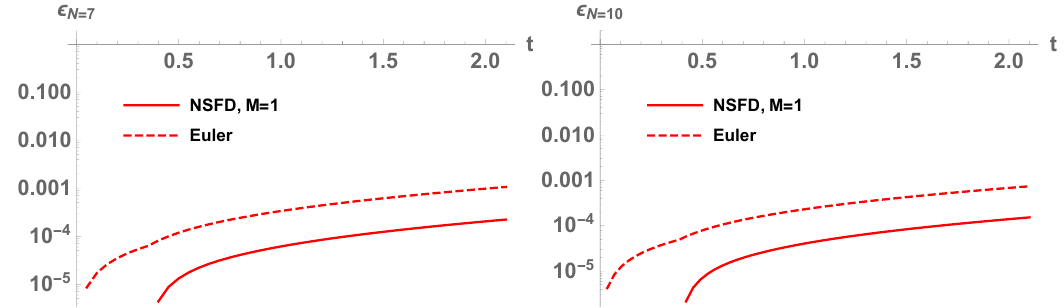
Figure 7. Absolute errors (log-scale) in the approximation of the mean value, with Euler’s method (dashed lines) and with the NSFD scheme M = 1 (solid lines). For step size h = τ / N , the left panel corresponds to N = 7 and the right panel to N = 10. This figure corresponds to Example